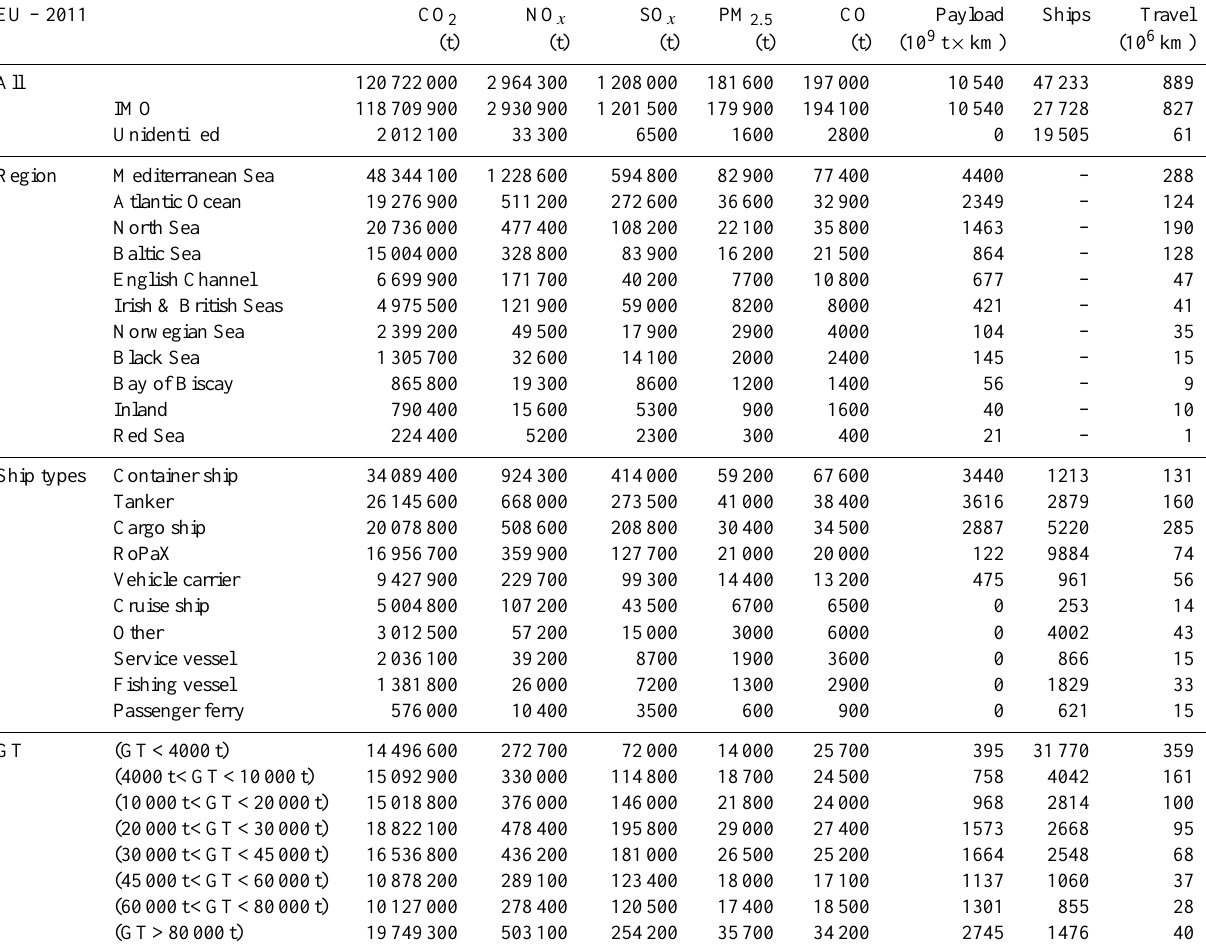
Table 1. Emissions and shipping statistics in the SafeSeaNet area in 2011. The section “All ships” includes also emissions from unidentified vessels. “IMO registered” refers to commercial ships with specified IMO number. In the section “GT”, eight vessel size categories and their contributions to emitted CO 2 are presented. The NO x emissions have been calculated as NO 2 and SO x as SO 2 . EU –